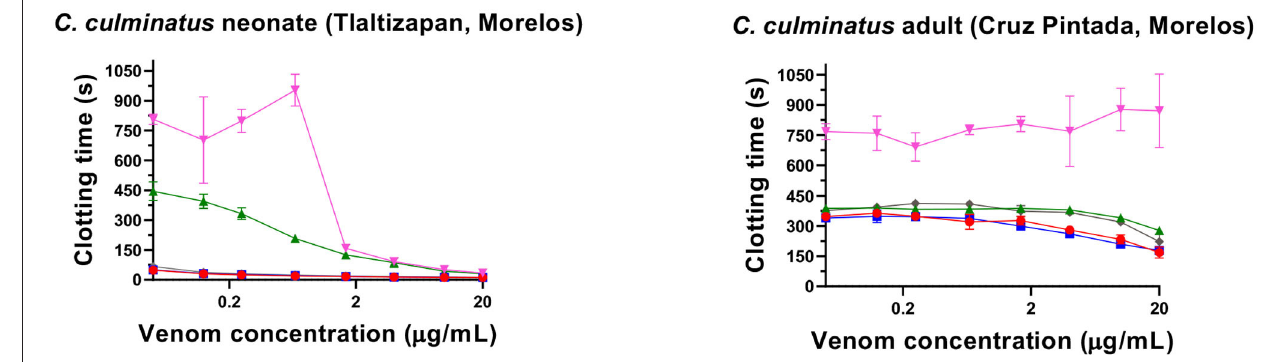
FIGURE 3 | Eight-point dilution curves for C. culminatus venom upon plasma (red lines for venom-only) against Antivipmyn ® antivenom (blue lines), 2mM Prinomastat hydrochloride with 2min incubation (green lines), 2mM DMPS with 2min incubation (pink lines). Spontaneous clotting control = 444.87 ± 26.73s. Prinomastat